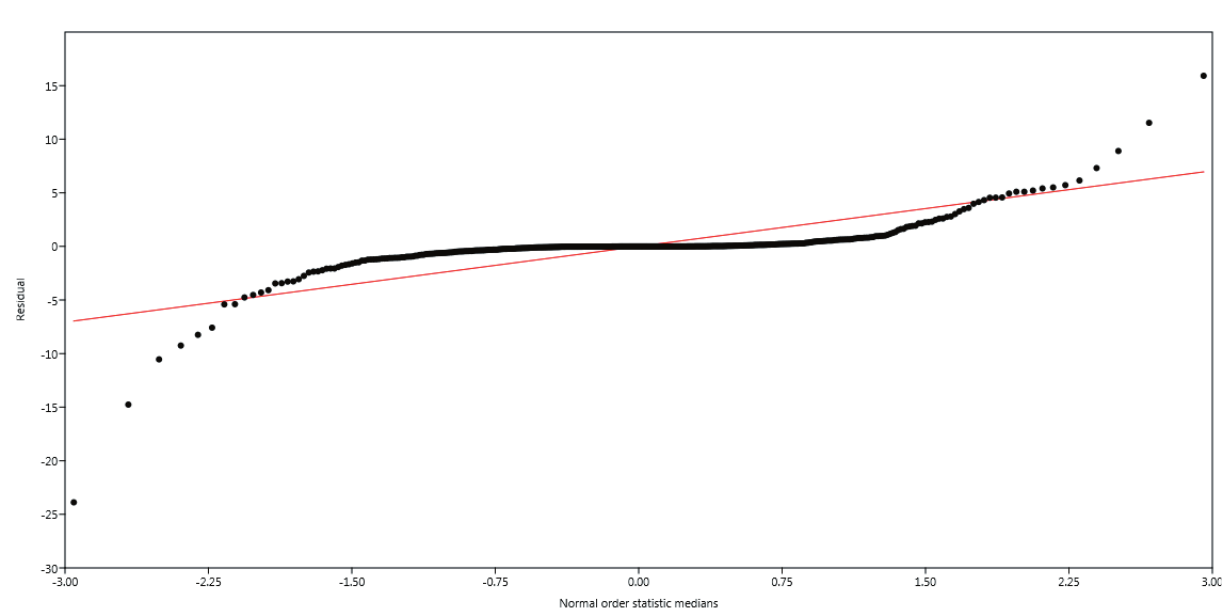
Figure 3. Shapiro - Wilk normality test.